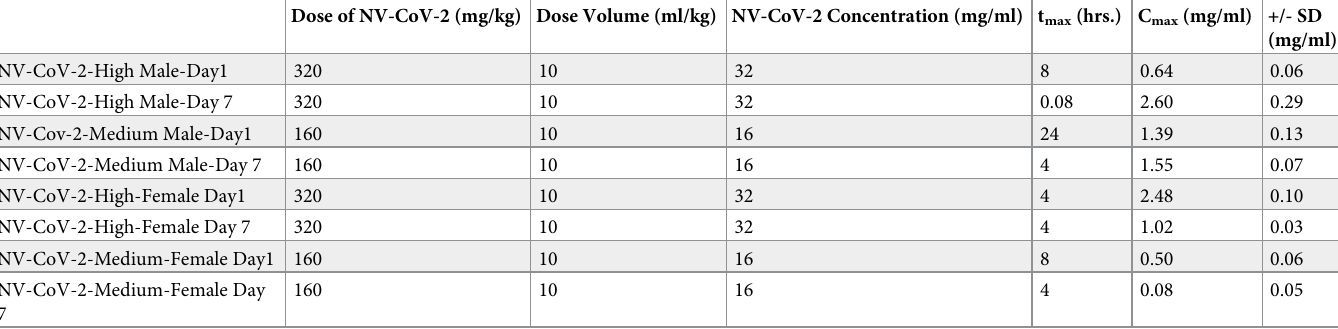
Table 4. Results of NV-CoV-2 pharmacokinetics analyses in groups treated with NV-